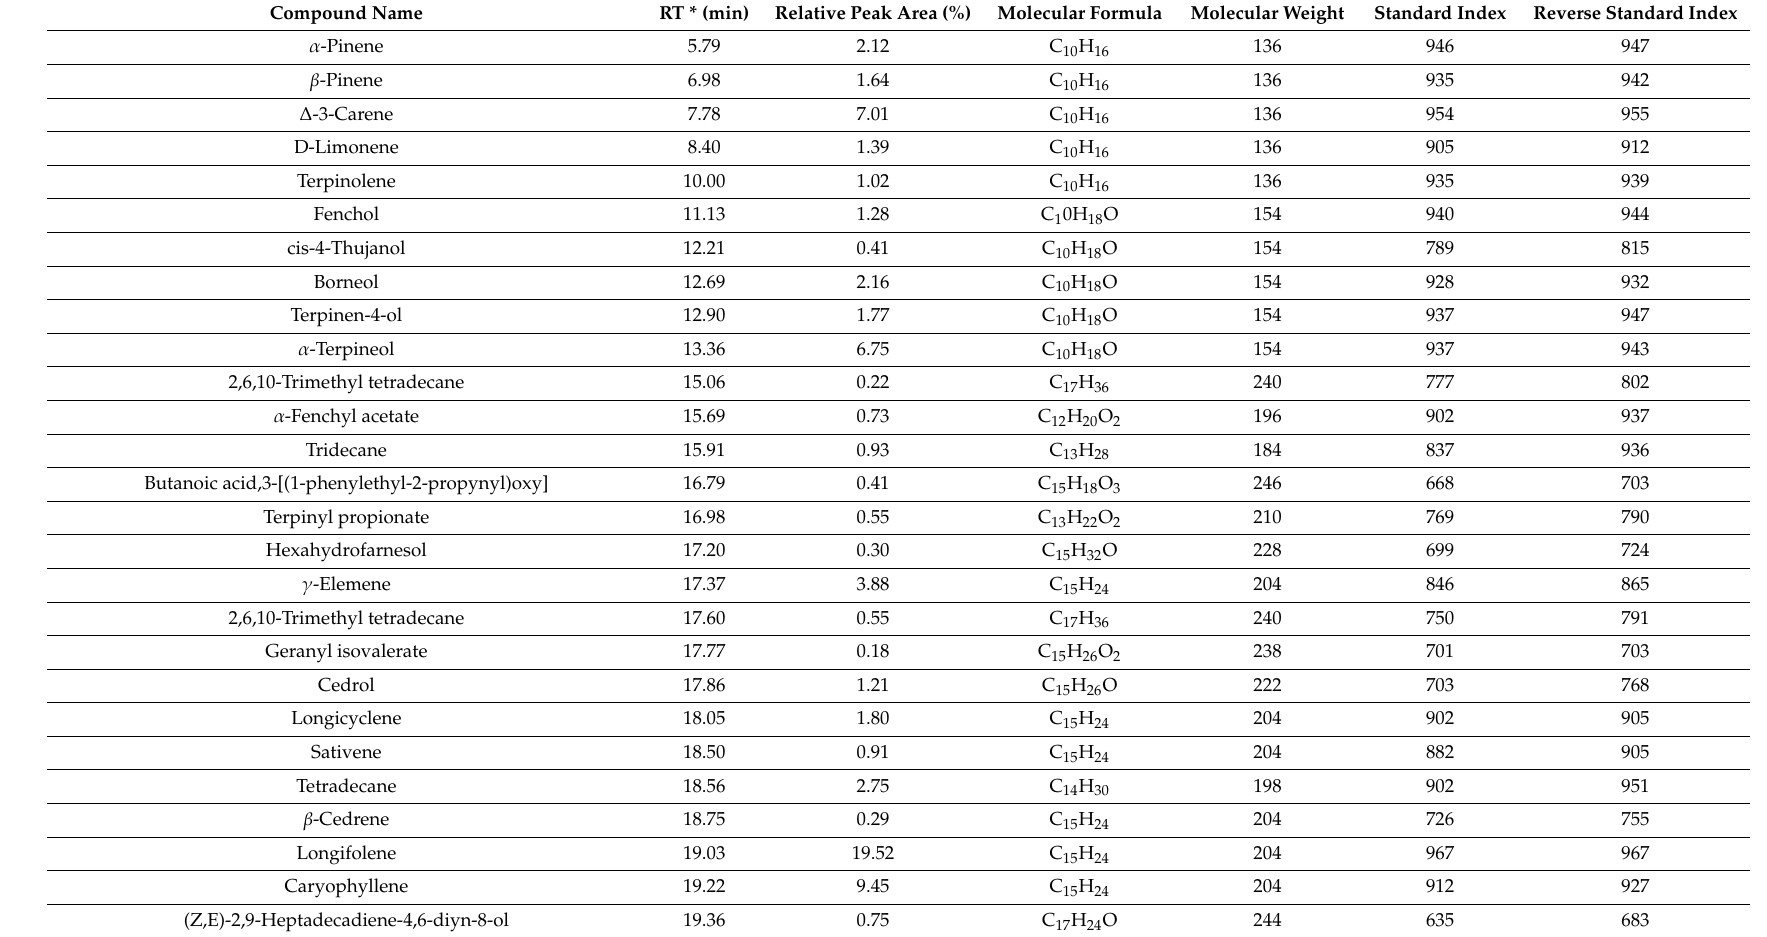
Table 3. Chemical composition of the oil from Pinus roxburghii